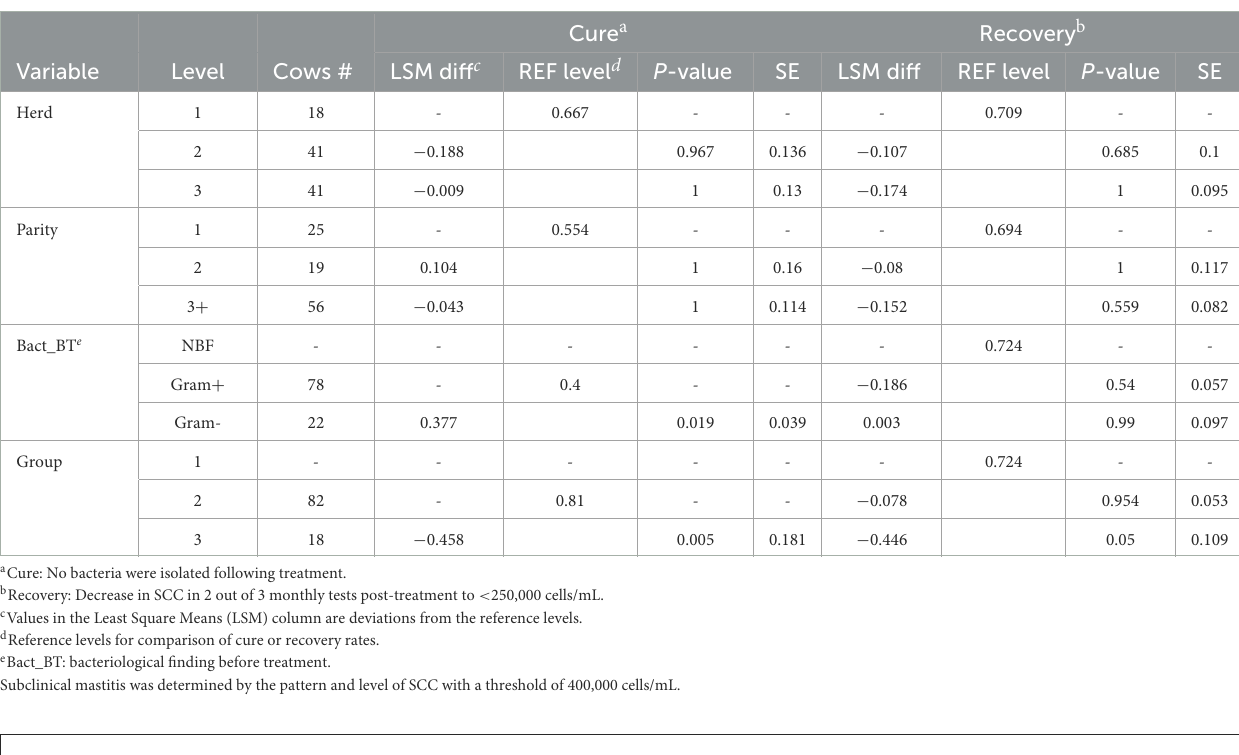
TABLE 2 The results of the generalized mixed model used to estimate the effect of APT treatment on cure and recovery rates in the cows ( n = 129, 3 herds) with clinical or subclinical mastitis caused by Gram-negative or Gram-positive bacteria or without bacterial findings.